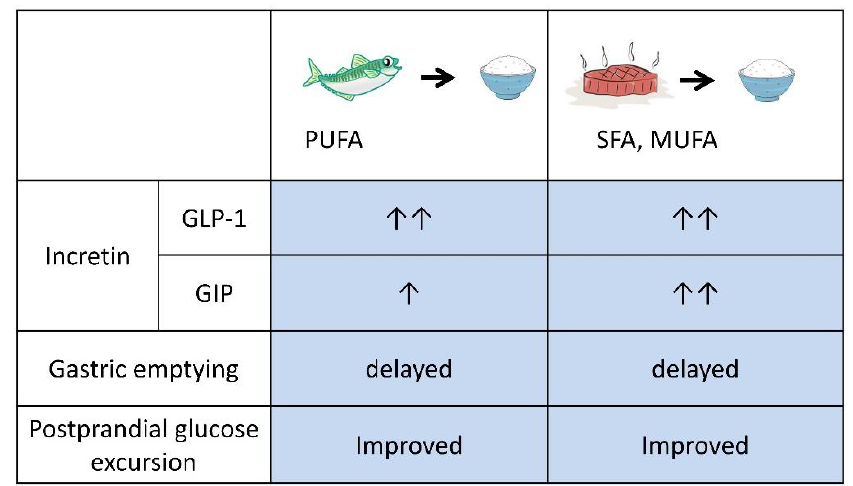
Figure 1. Summary of preloading fish and meat before carbohydrate. Preload of fish and meat ameliorated postprandial glucose excursion by enhancing GLP-1 secretion and delaying gastric emptying. Preload of meat, which is rich in saturated fat (SFA) and monounsaturated fat (MUFA), enhances glucose-dependent insulinotropic polypeptide (GIP) secretion more than fish, which is rich in polyunsaturated fat (PUFA). As GIP promotes fat accumulation, frequent preload of meat before carbohydrate might well increase body weight.